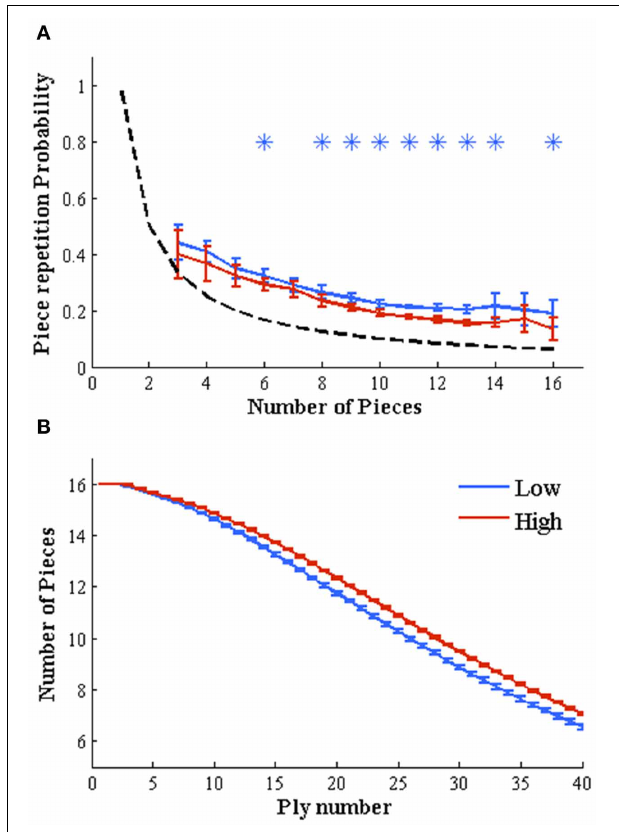
FIGURE 2 | Object-based mechanisms depend on expertise level. (A) Weak players repeat the same piece on consecutive movements more frequently than strong players. Probabilities to repeat the same piece on two consecutive moves depends on the remaining number of pieces on the board. We plotted this probability vs. the number of pieces for both expertise levels. Independent two-sample t -tests (high vs. low expertise probabilities) for each number of pieces left (ranging from 1 to 16) evidence a higher probability to move the same piece on consecutive movements for low rated players, almost independently of the number of remaining pieces ( ∗ p < 0 . 001 Bonferroni corrected for multiple comparisons). Dashed black line shows the random threshold. (B) Low-rated players reduce the number of pieces more rapidly than high-rated players. The number of remaining pieces over the board, which change throughout the game (starting in 16 pieces for each player), is significantly higher for high rated players along the whole game (moves 3–40, independent two-sample t -tests on each move number, ∗ p < 0 . 001 Bonferroni corrected for multiple comparisons), evidencing than low rated players exchange (or loss) their pieces more rapidly than stronger